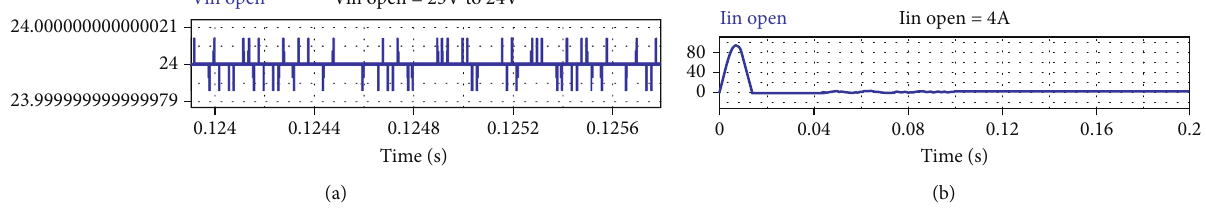
Figure 11: (a) Input voltage V